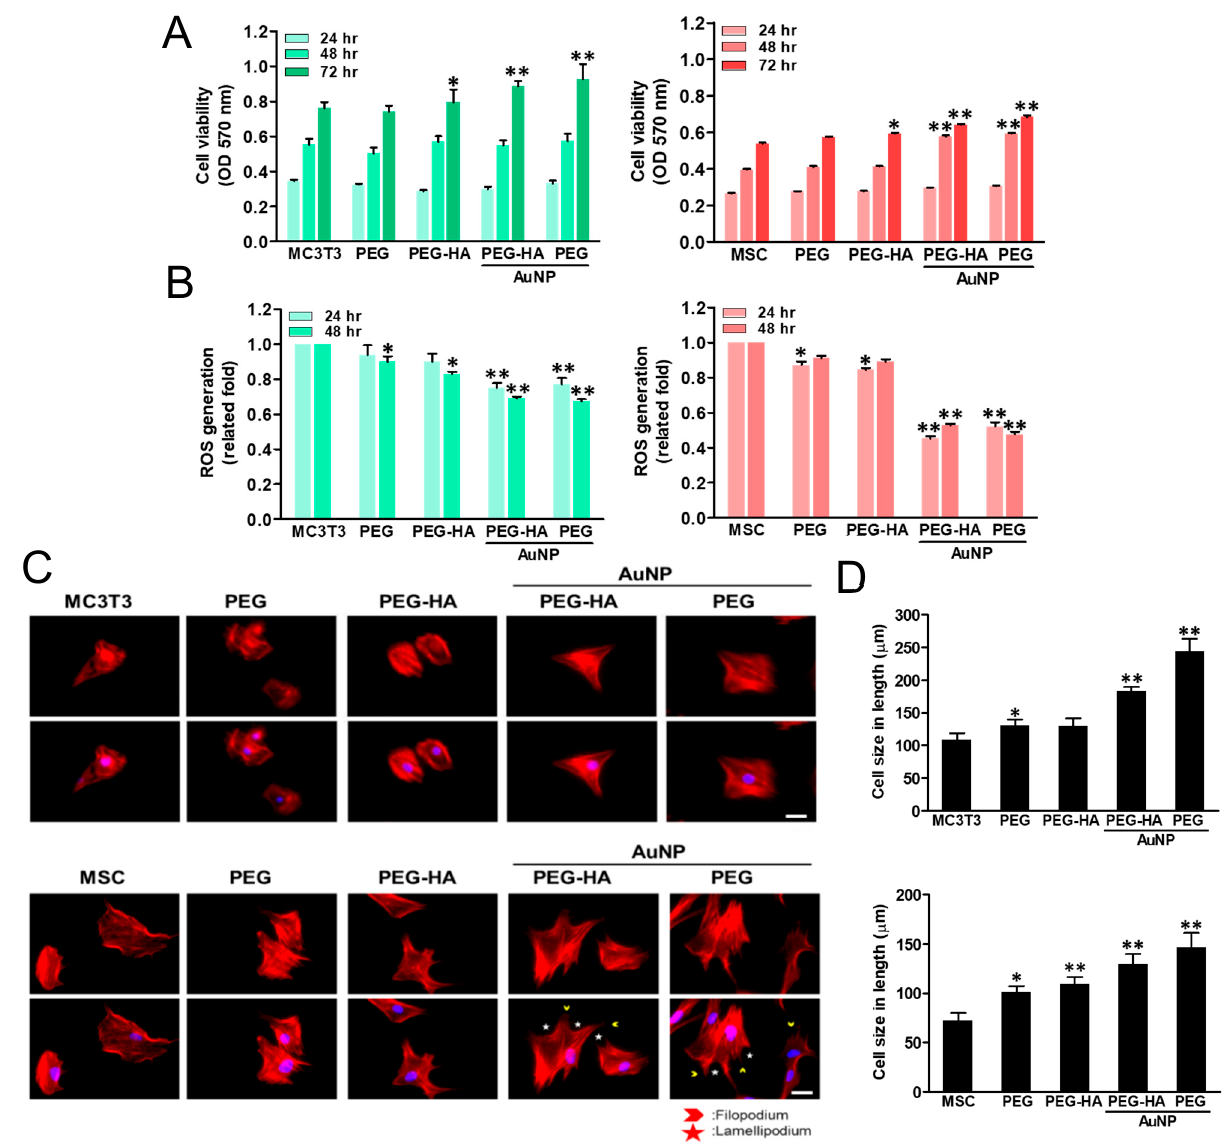
Figure 5. Cell proliferation of ( A ) MC3T3 cells and MSCs was promoted by culturing them on PEG-HA-AuNPs and PEG- AuNPs. Data are the mean ± SD ( n = 3), * p < 0.05; ** p < 0.05. Reactive oxygen species (ROS) generation assay of ( B ) MC3T3 cells and MSCs on different materials after 48 h of incubation. Intracellular ROS quantified by 2,7-dichlorofluorescein diacetate (DCFH-dA) and flow cytometric analysis. * p < 0.05; ** p < 0.01: smaller than control (TCPS). Cytoskeleton and cell morphology by rhodamine phalloidin staining of ( C ) MC3T3 cells and MSCs for actin fiber extension on different materials after 24 h of incubation under fluorescence microscopy analysis. Scale bar = 20 µ m. Arrows indicate filopodia (green color) and lamellipodia (red color). Data are the mean ± SD ( n = 3). Actin fiber extension in length quantified by Image J software in ( D ) MC3T3 cells and MSCs on different materials after 8 h is shown. Actin fiber length elongation was significantly observed in the PEG-HA-AuNP and PEG-AuNP test groups compared with the other groups. Data are mean ± SD ( n = 3). * p < 0.05; ** p < 0.05. Scale bar = 50 µ